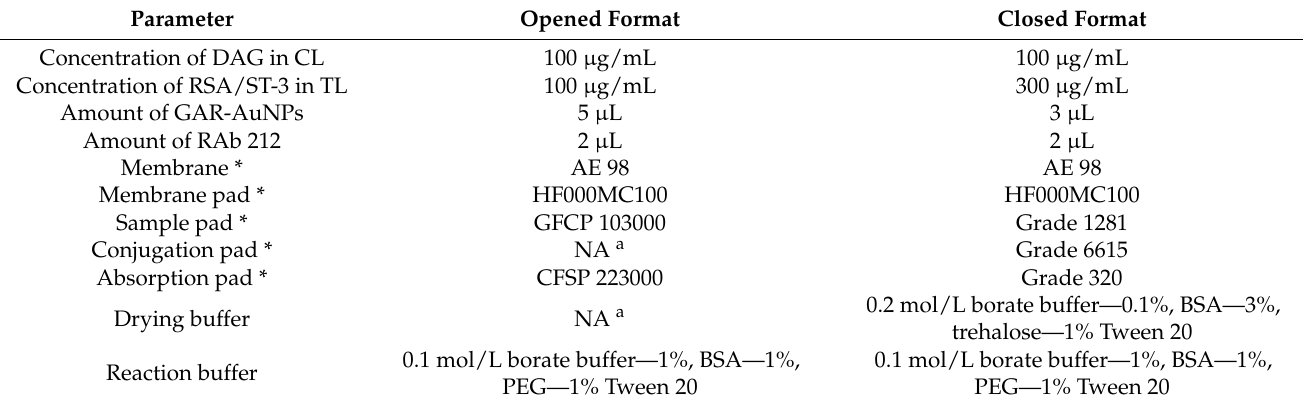
Table 1. A summary of optimized conditions for indirect ICT